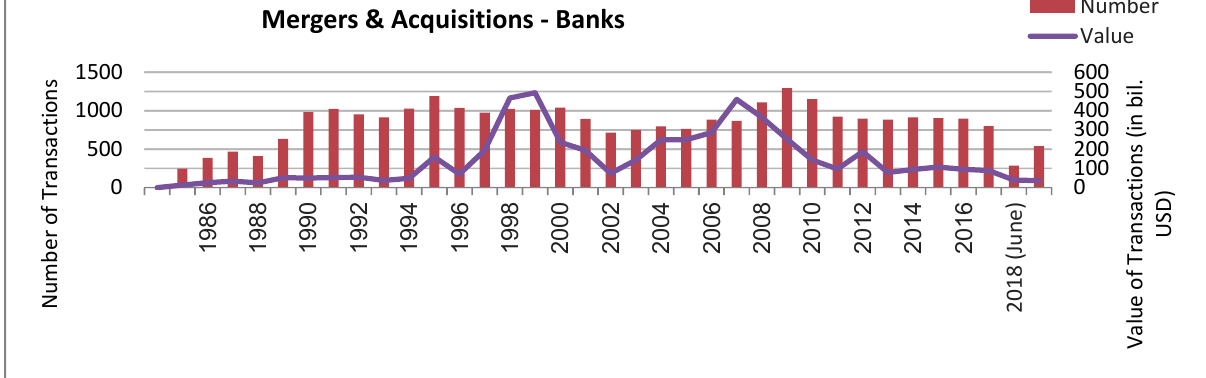
Fig. 1. Exhibits the Merger and Acquisition(M&As) in the Banking Sector around the